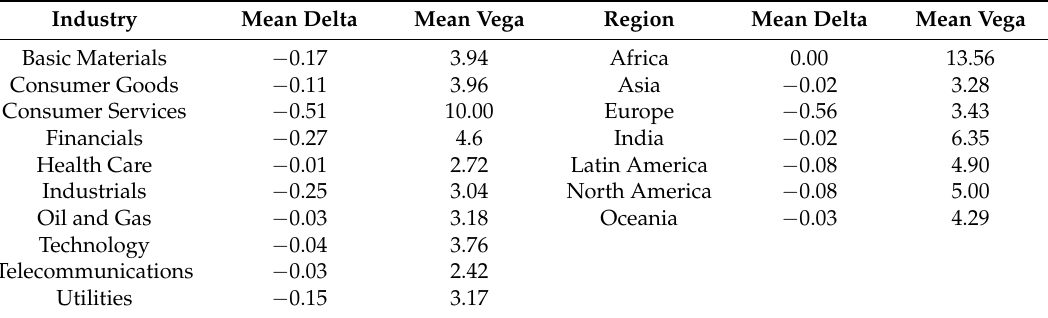
Table 4. Empirical sensitivity breakdown by industry and region 1